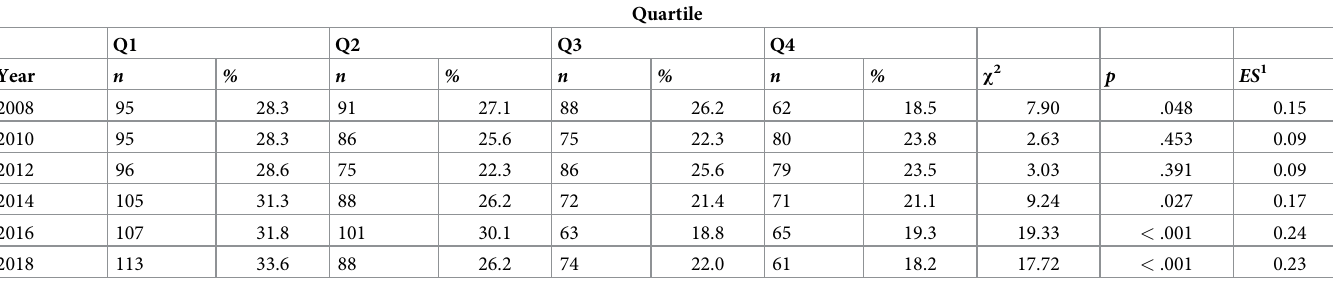
Table 3. Distribution of birth dates in female soccer players participating in under-17 world cup 2008–2018. Q1